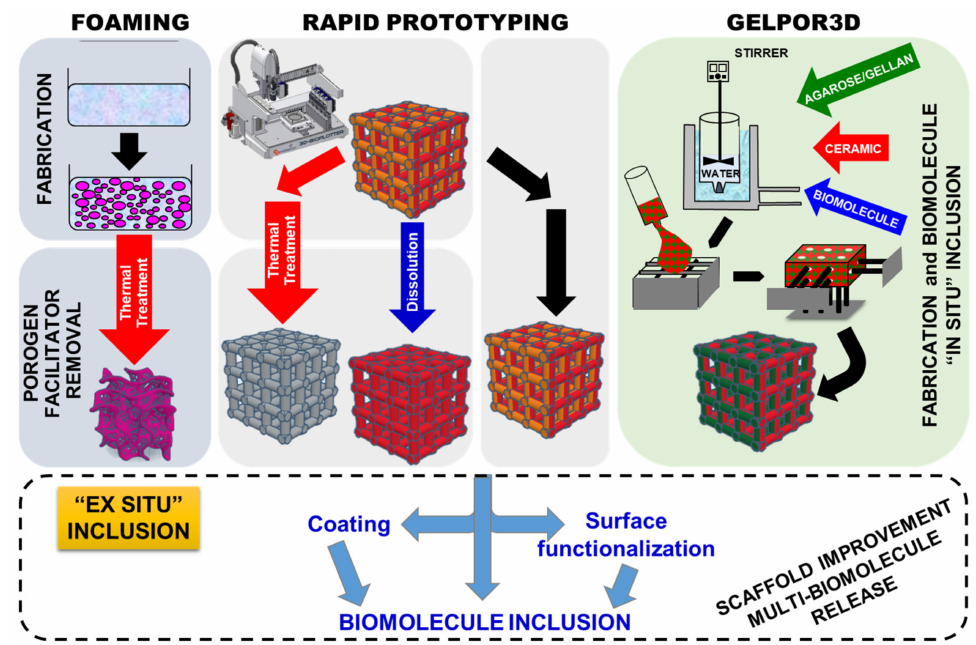
Figure 1. Schematic representation of the different scaffolds fabrication technologies employed as well as the additional routes designed to improve and tailor their final